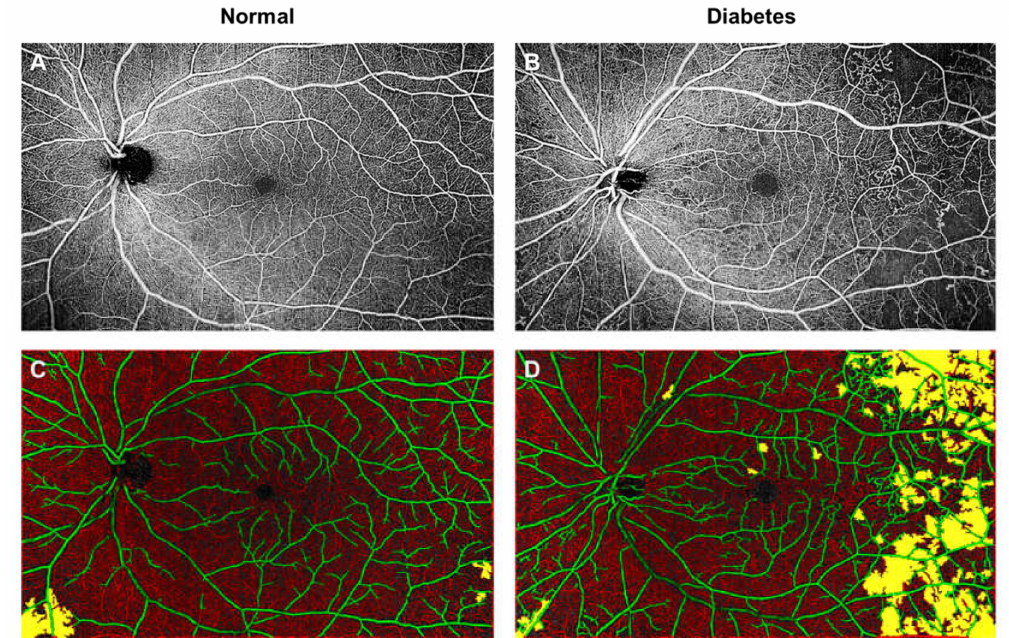
Figure 5. Widefield optical coherence tomography angiography (OCTA; 15 × 9 mm area; A , B ) and color-coded maps indicating regions of low or nonperfusion ( C , D ; labelled as yellow) of a superficial vascular plexus of a healthy control individual (Left panel; A – C ) and a diabetic (Right panel; B – D ). There are increased regions of retinal nonperfusion, particularly in the temporal regions in a diabetic eye (D; labelled as yellow). It is important to note that in the normal subject, sporadic yellow areas can be seen in the peripheral region ( C ; labelled as yellow). These yellow areas were segmented out, because they were areas of low intensity and not of low